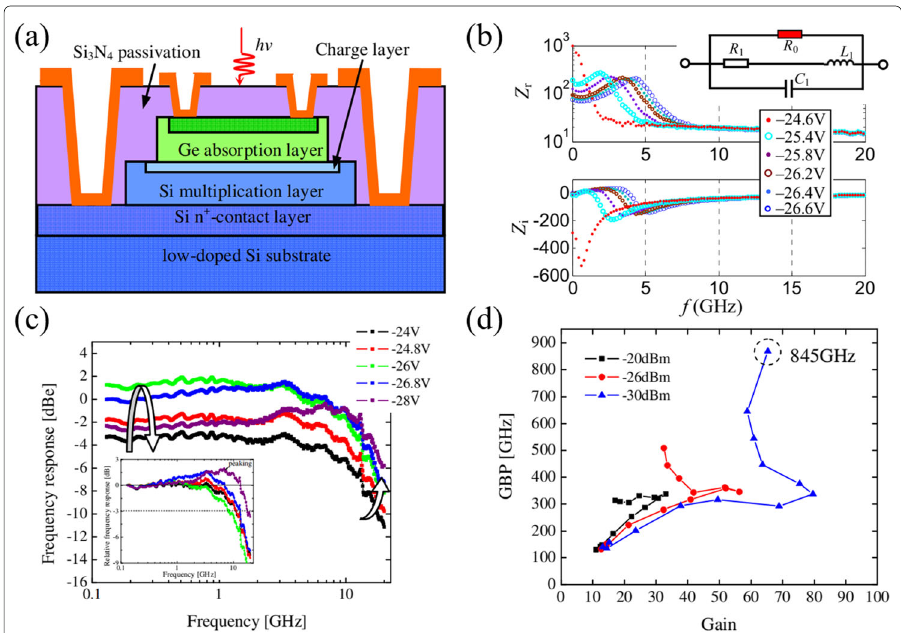
Fig. 5 a Schematic cross-section of the resonant normal incident Si-Ge SACM APD [90]; b Measured APD RF impedance. The top is the real part and the bottom is the imaginary part. Inset is the equivalent circuit of the device avalanche region [91]; c Measured frequency response at different bias voltages under -20 dBm input opticalpower[73]; d